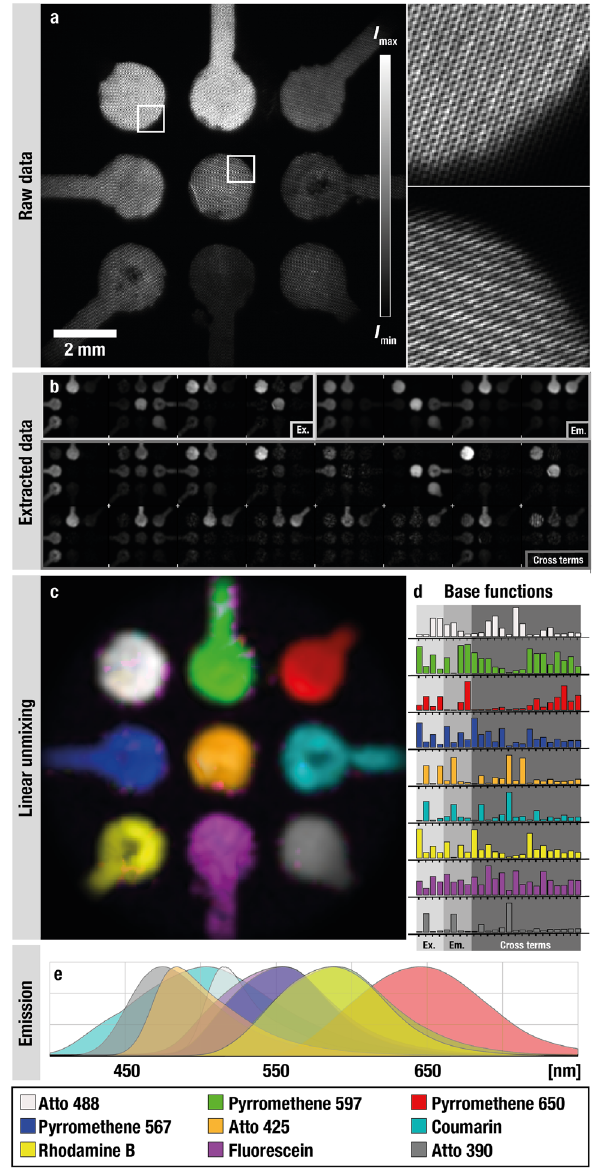
Figure 4. Linear unmixing of nine fluorophores. Nine fluorophores were probed using DM-FRAME where ( a ) is the raw unprocessed image as seen by the camera. The beating patterns, faintly visible in the magnified views, correspond to the doubly modulated information. ( b ) From the acquired data, 24 spectral images were extracted and subsequently used to perform the linear unmixing of the data. ( c ) The outcome of the spectral analysis, showing the nine different fluorophores in false colors. ( d ) The base functions (reference responses) for all nine fluorophores, where each fluorophore can be seen to acquire a unique footprint when imaged through the DM-FRAME system. ( e ) The spectrally resolved fluorescence signal (excitation 405 nm) for all nine fluorophores, indicating strong overlap of the featureless